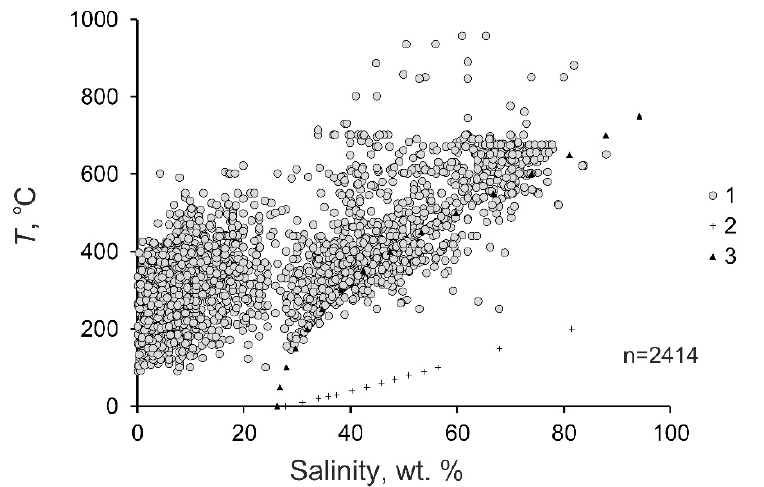
Figure 3. Diagram temperature–salinity for mineralizing fluids at porphyry deposits. 1—fluids at the deposits; 2—saturated KCl solution; 3—saturated NaCl solution.